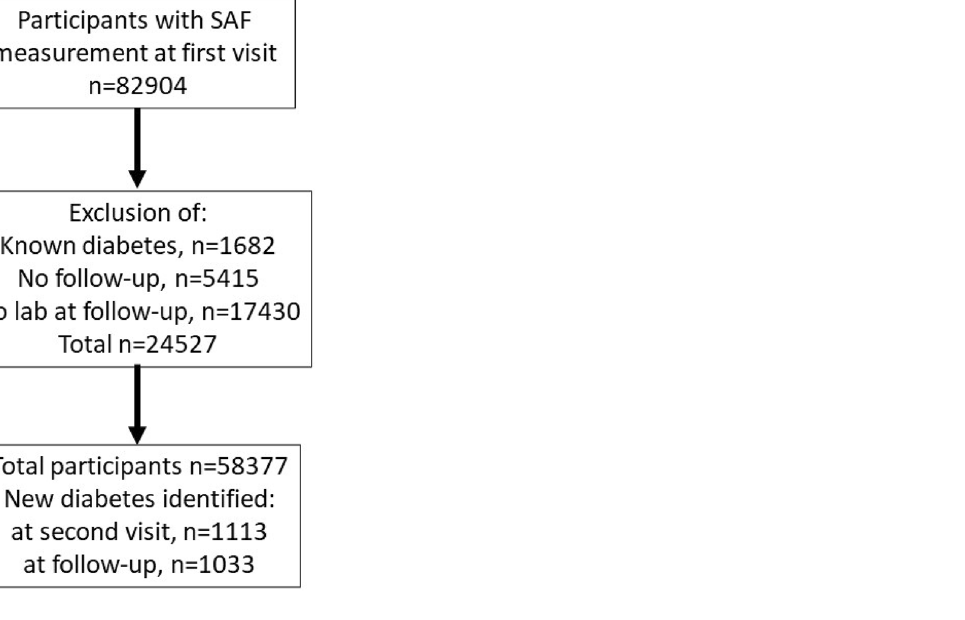
Figure 1. Disposition of lifelines